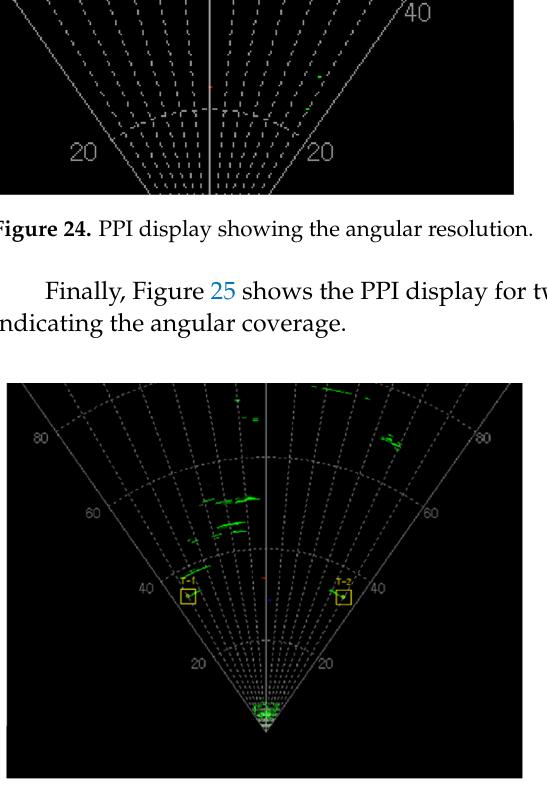
Figure 25. PPI display showing the angular coverage.